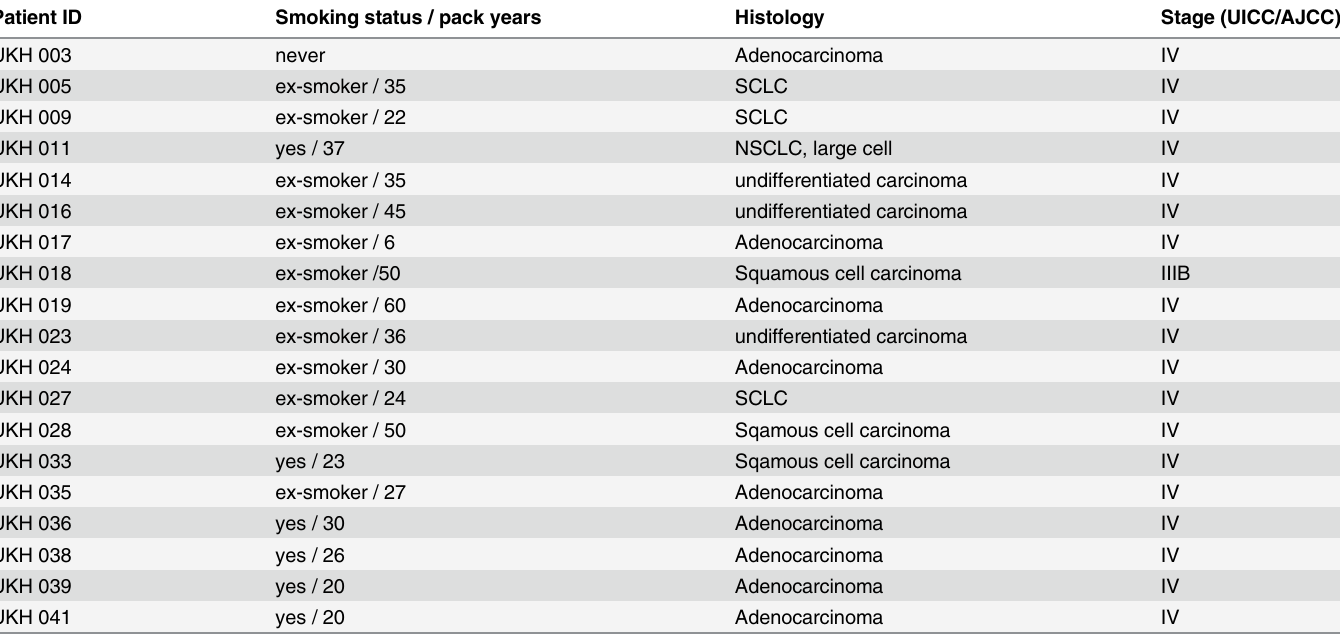
Table 1. Clinical data of patients not responding to the therapy.